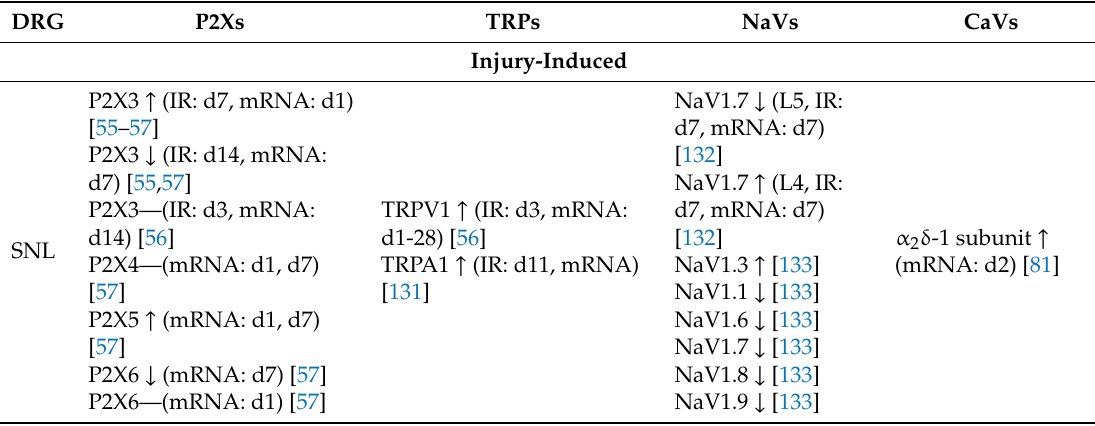
Table 2. Molecular mediators of neuropathic pain in focal neuropathy